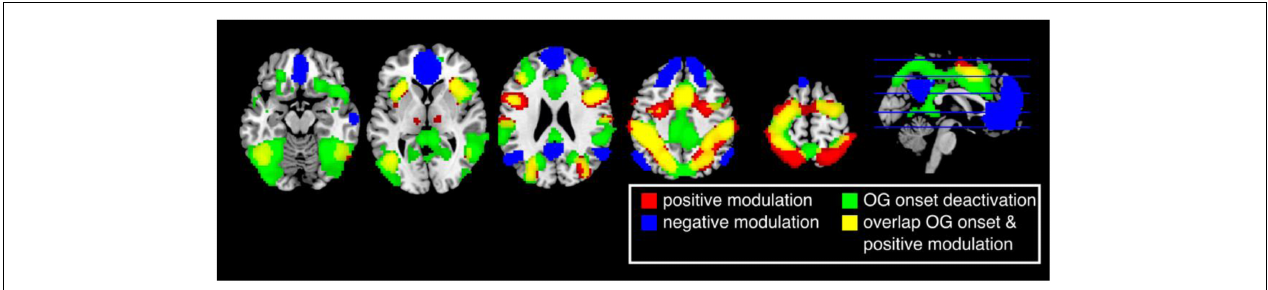
FIGURE 3 | Results of the parametric general linear model. Positively modulated regions (red) are more active when participants respond relatively slow. Negatively modulated regions (blue) are more active when participants respond relatively fast. Brain regions that are deactivated by the task (green) highly overlap with regions that are positive modulated (yellow) ( p < 0.05, FWE corrected at the voxel level).